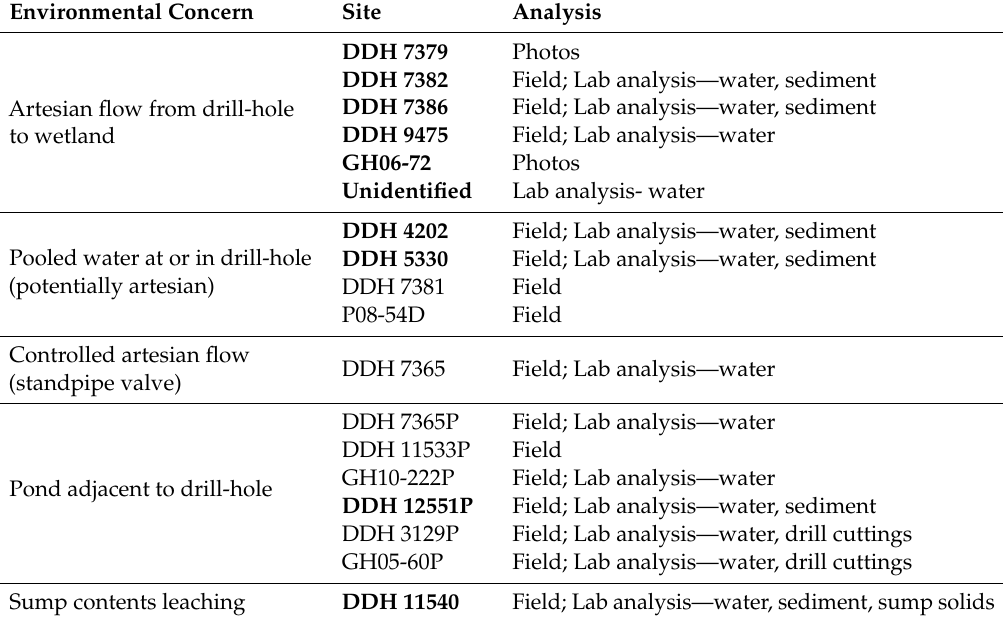
Table 1. Sample set at drill-holes. Only sites with potential water quality concerns based on visual evidence or proximity to water bodies are listed. Bold—sites with impacts to water quality. Two unsampled artesian sites are included in the list of impacted sites based on artesian water chemistry of sampled sites.